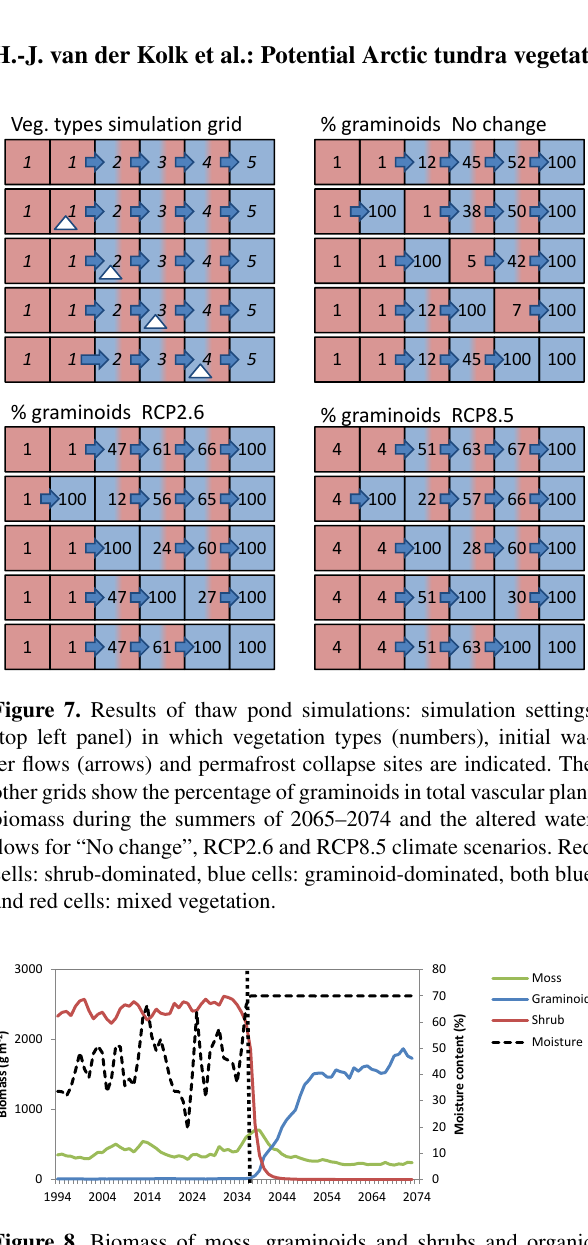
Figure 8. Biomass of moss, graminoids and shrubs and organic layer moisture content during the thaw pond formation simulation in an initially dry shrub-dominated vegetation type (1) under the “No change” scenario. The dotted line indicates the moment of ice wedge